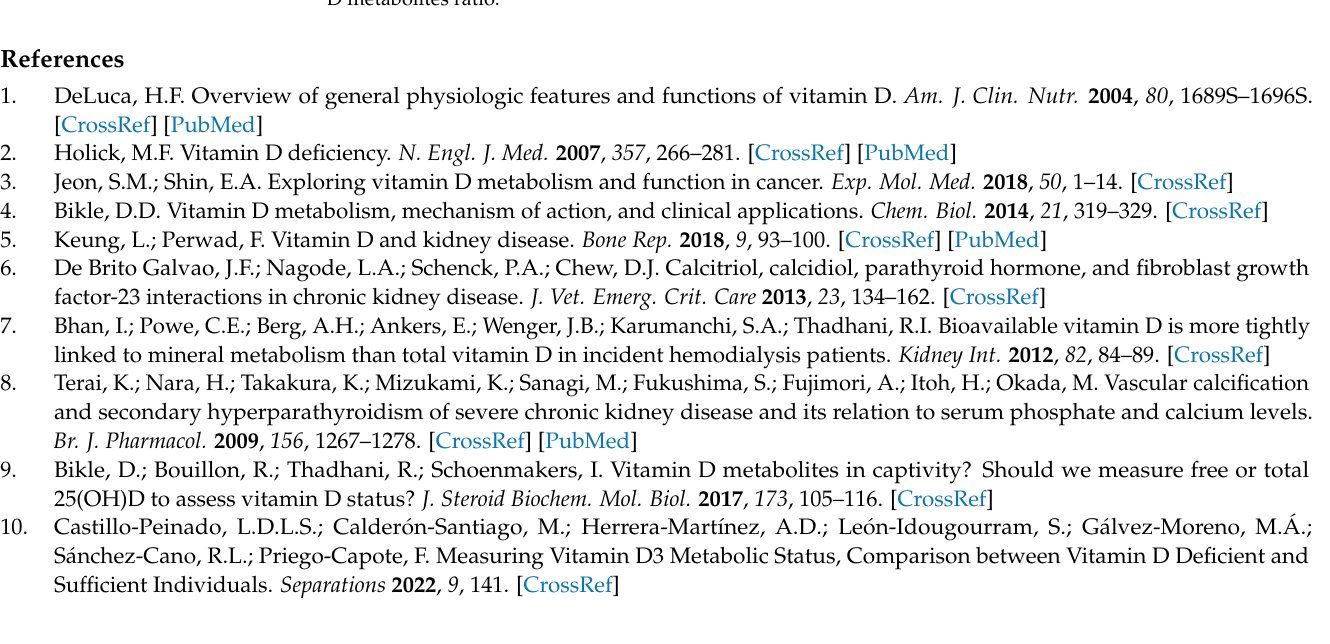
Abbreviations: Ca × P, calcium–phosphate product, eGFR, estimated glomerular filtration rate; iPTH, intact parathyroid hormone; 25(OH)D, 25-hydroxy vitamin D; 24,25(OH) 2 D, 24,25-dihydroxy vitamin D; VMR, vitamin D metabolites